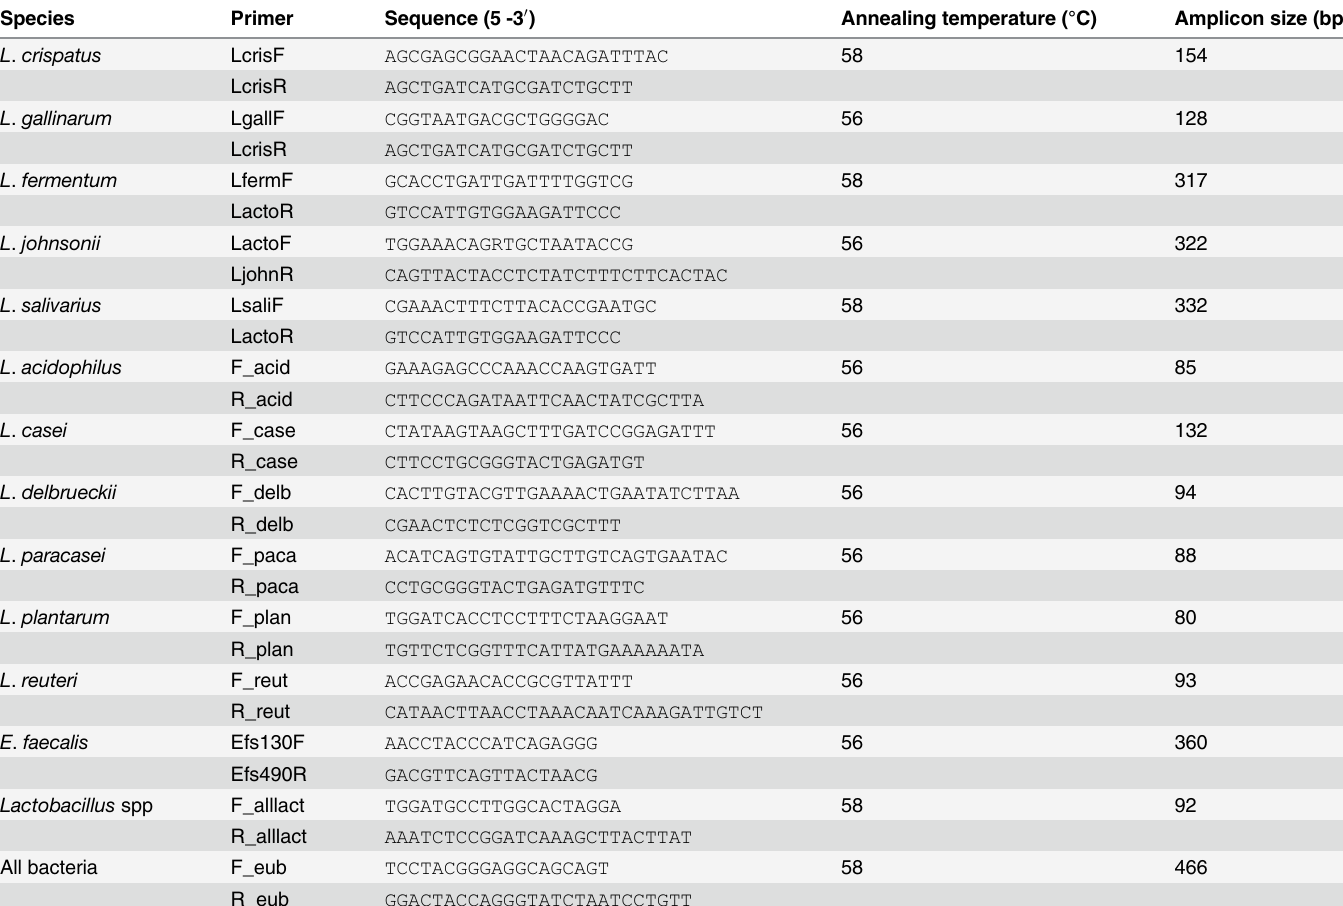
Table 1. Sequencing primers for the Lactobacillus species used in this